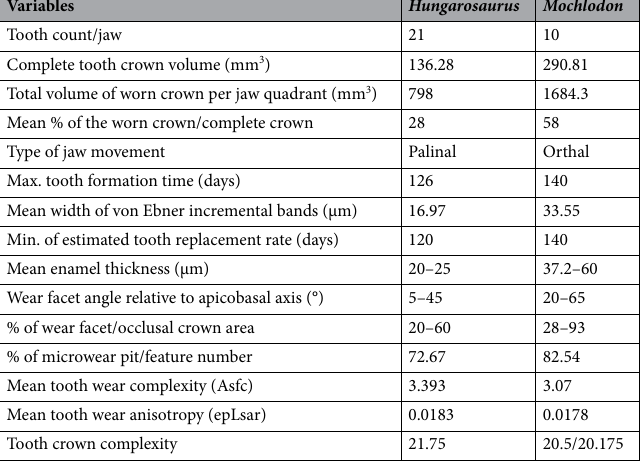
Table 1. Comparison of feeding-related dental characters in Hungarosaurus and Mochlodon used in this study.